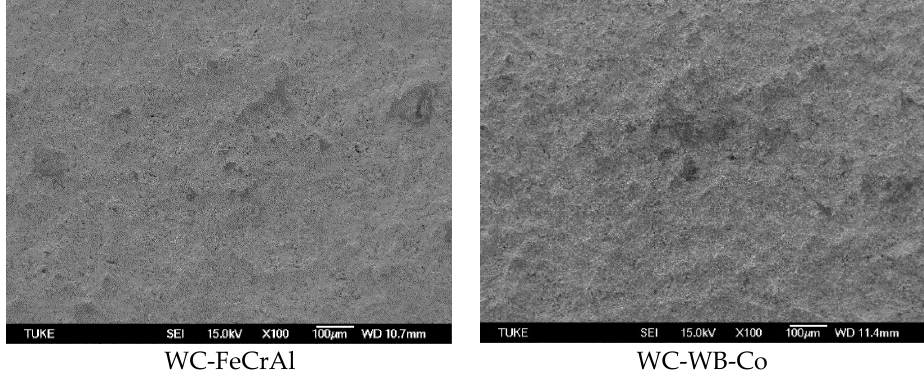
Figure 16. Appearance of coatings’ surfaces in and out of wear track (SEM).